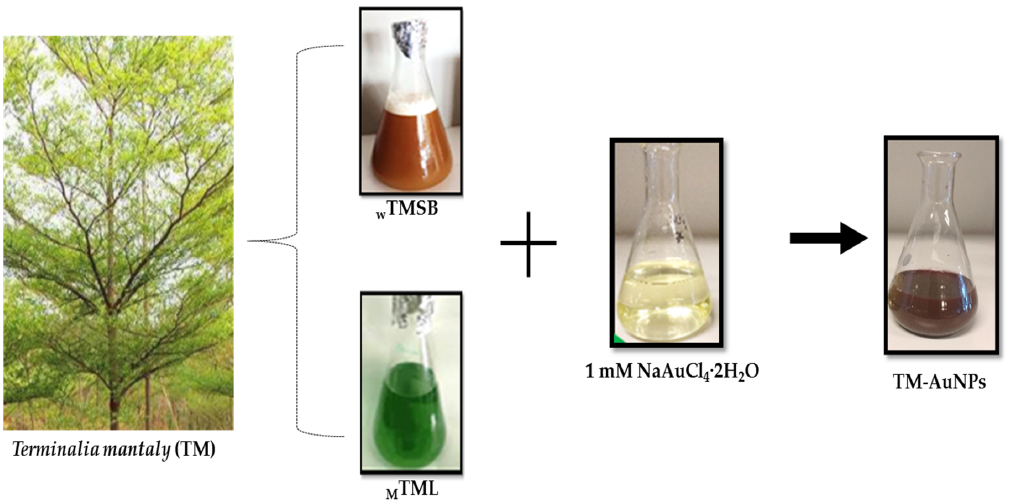
Figure 1. One step synthesis of TM-gold nanoparticles (AuNPs) by the reduction of chloroaurate ions by TM extracts. The W TM and M TM extracts of leaf, root and stem / bark parts of the plant were prepared and mixed with NaAuCl 4 ·2H 2 O. The appearance of a red wine/ruby red color indicated the formation of the AuNPs.